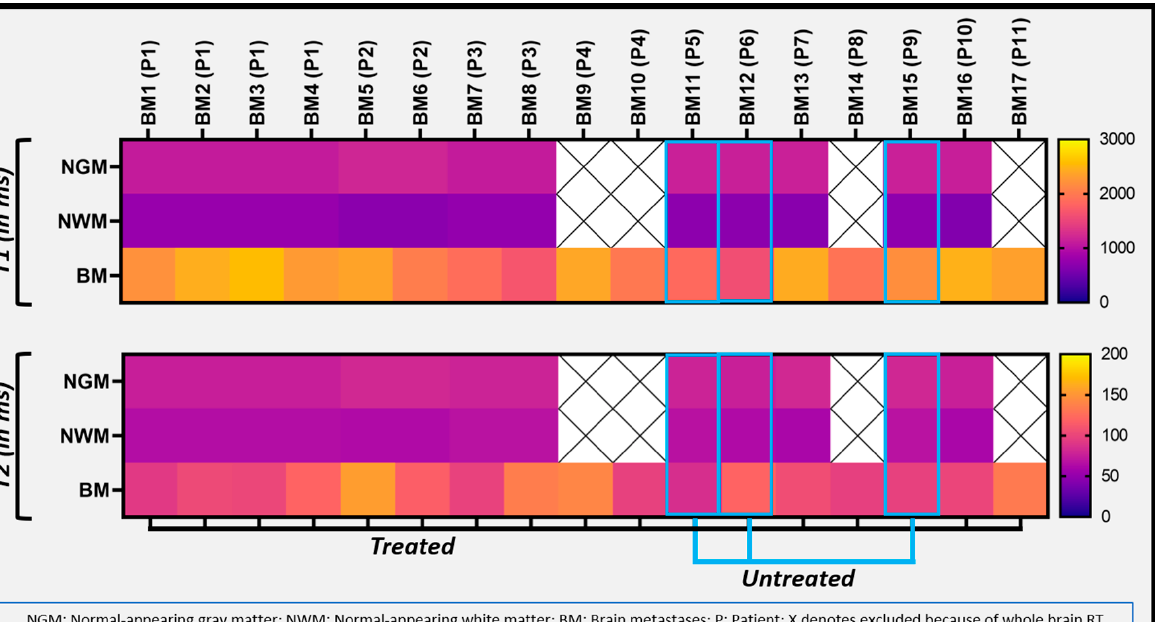
Figure 5. The heat map exhibits the T1 and T2 metric values of all the BM lesions and normal-ap- pearing GM and WM. appearing GM and